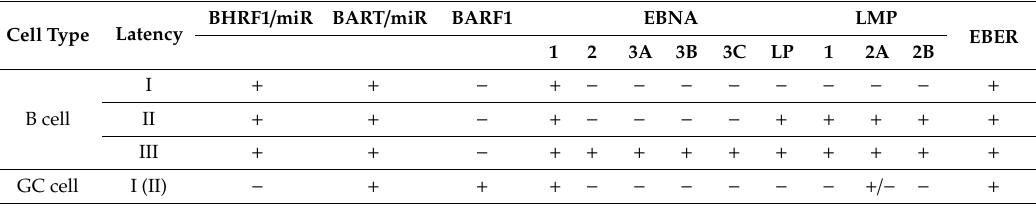
Table 2. Expression patterns distinguishing the di ff erent forms of EBV latency.